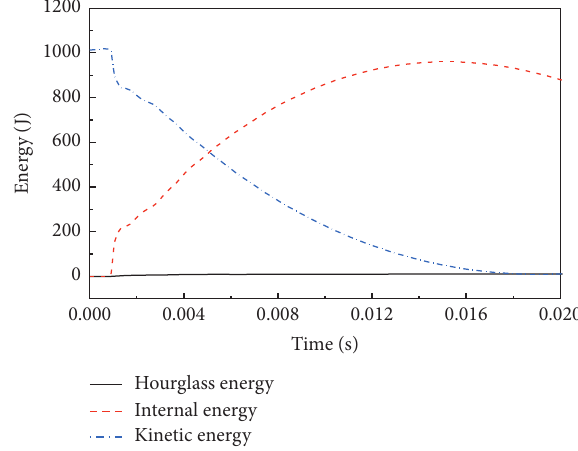
Figure 14: Energy time-history curve.